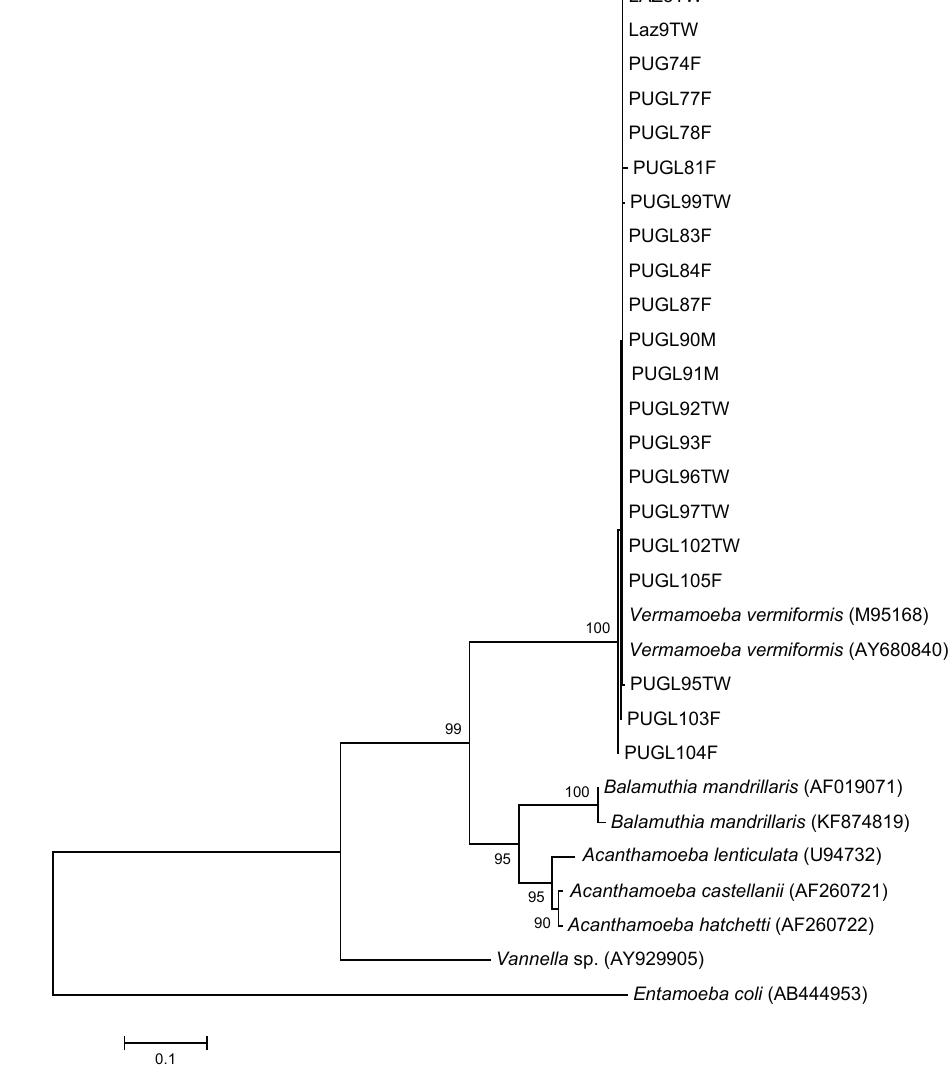
Figure 3. Phylogenetic relationships of 21 FLA isolates inferred by NJ analysis based on 18S ribosomal DNA sequences. Only bootstrap values >70 are reported. GenBank accession numbers of reference strains are indicated in